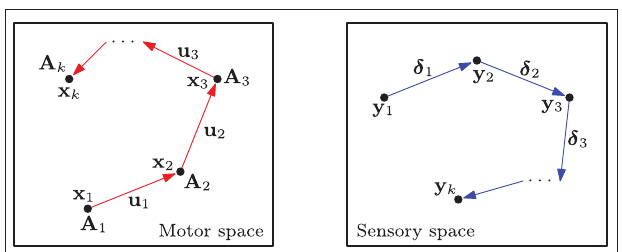
FIGURE 1 | Representation of a configuration trajectory x t , its associated transformation matrices A t and motor actions u t , that produce the measurements y t and sensory changes δ t